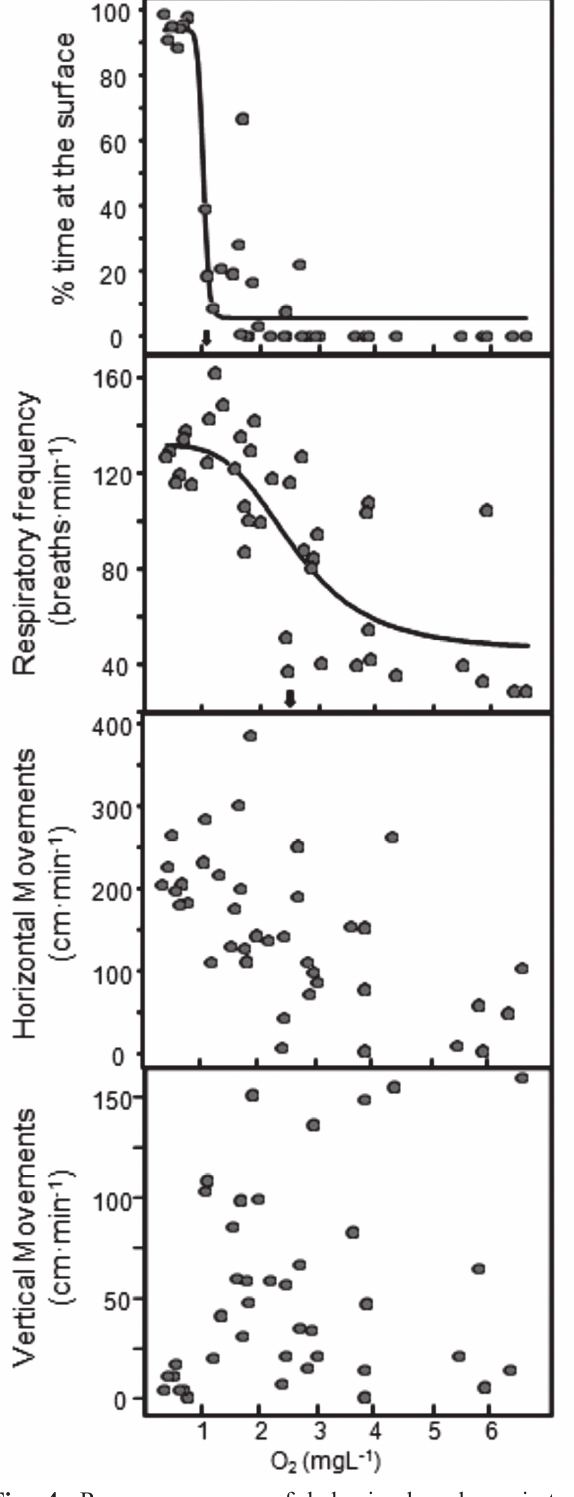
Fig. 4. Response curves of behavioral and respiratory variables of Piaractus mesopotamicus respect to dissolved oxygen gradient. Black arrow indicates inflection point given by the four parameters logistic function. The curve fitted to data points is not shown for horizontal and vertical movements due to the great dispersion.